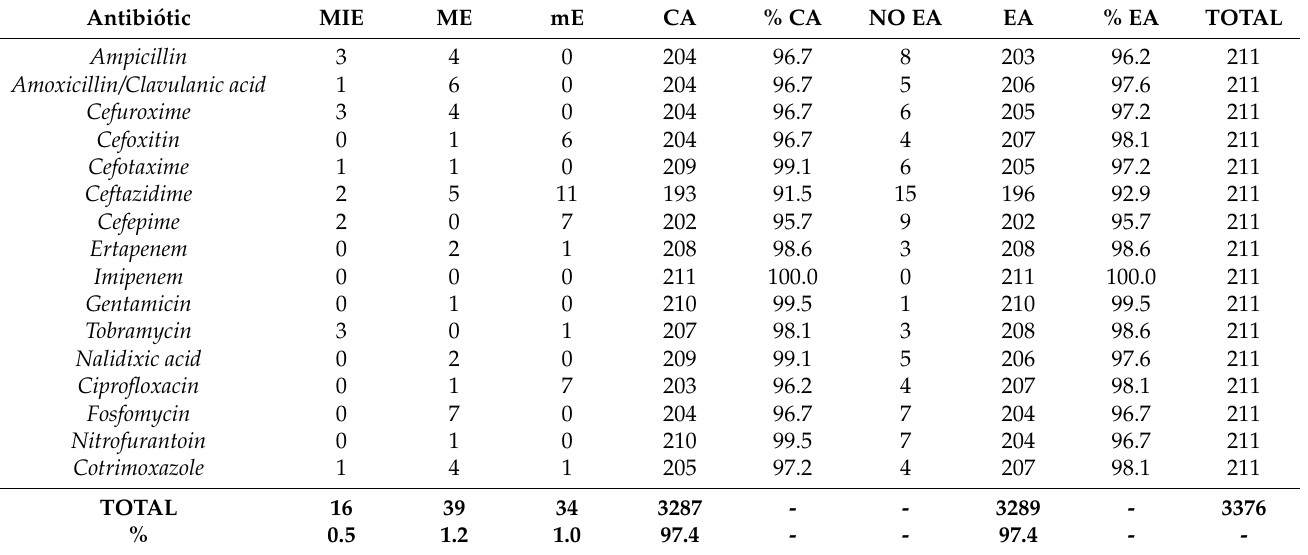
Table 1. Results of the experimental method showing the errors and agreements compared to the reference